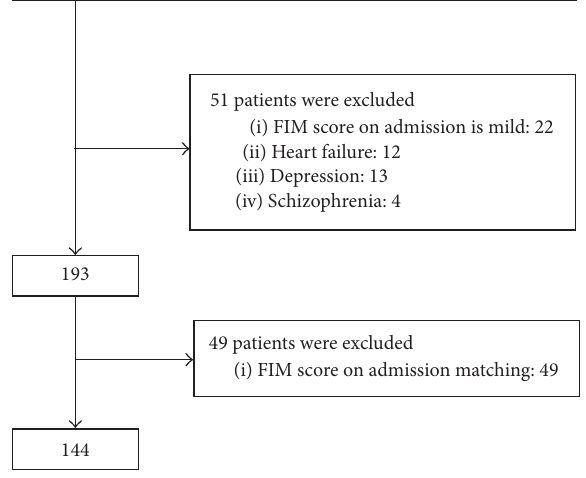
nonpolypharmacy group (FIM-C at discharge: 25.0 ± 7.7 points versus 28.1 ± 6.4 points, 𝑝 = 0.011 ; FIM-T efficiency: 0.15 ± 0.14 versus 0.23 ± 0.17 , 𝑝 = 0.007 ; FIM-M